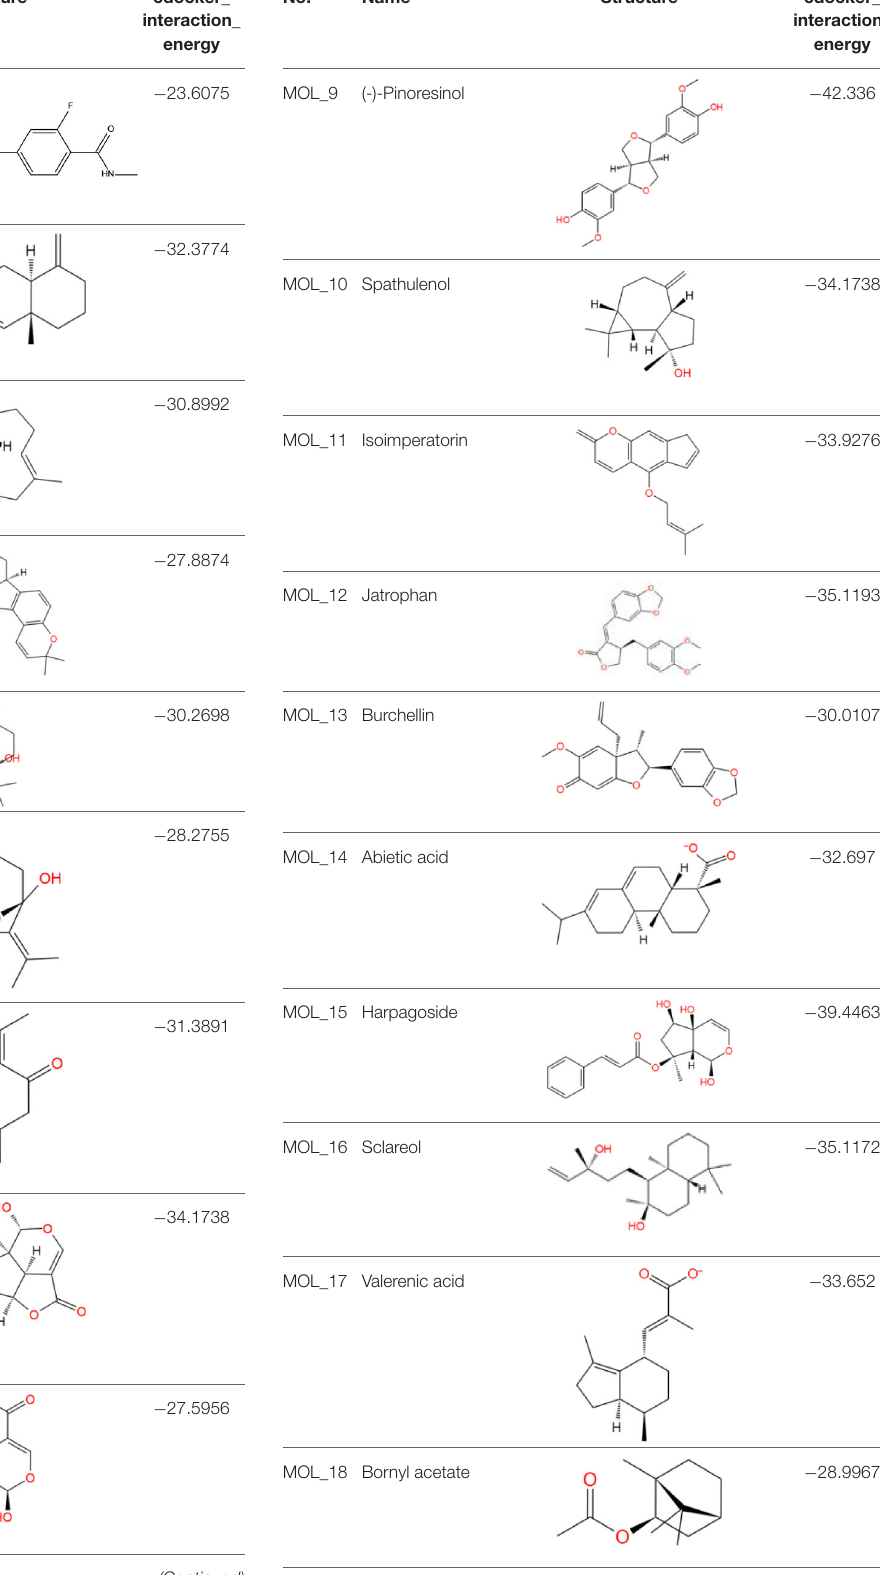
TABLE 2 | The obtained potential ingredients by virtual screening.